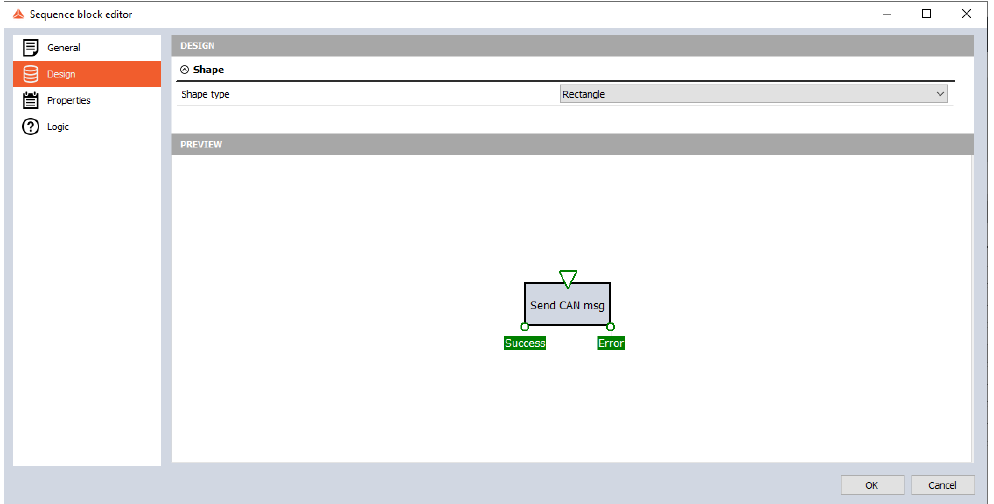
Figure 13. Visual block editor for an advanced